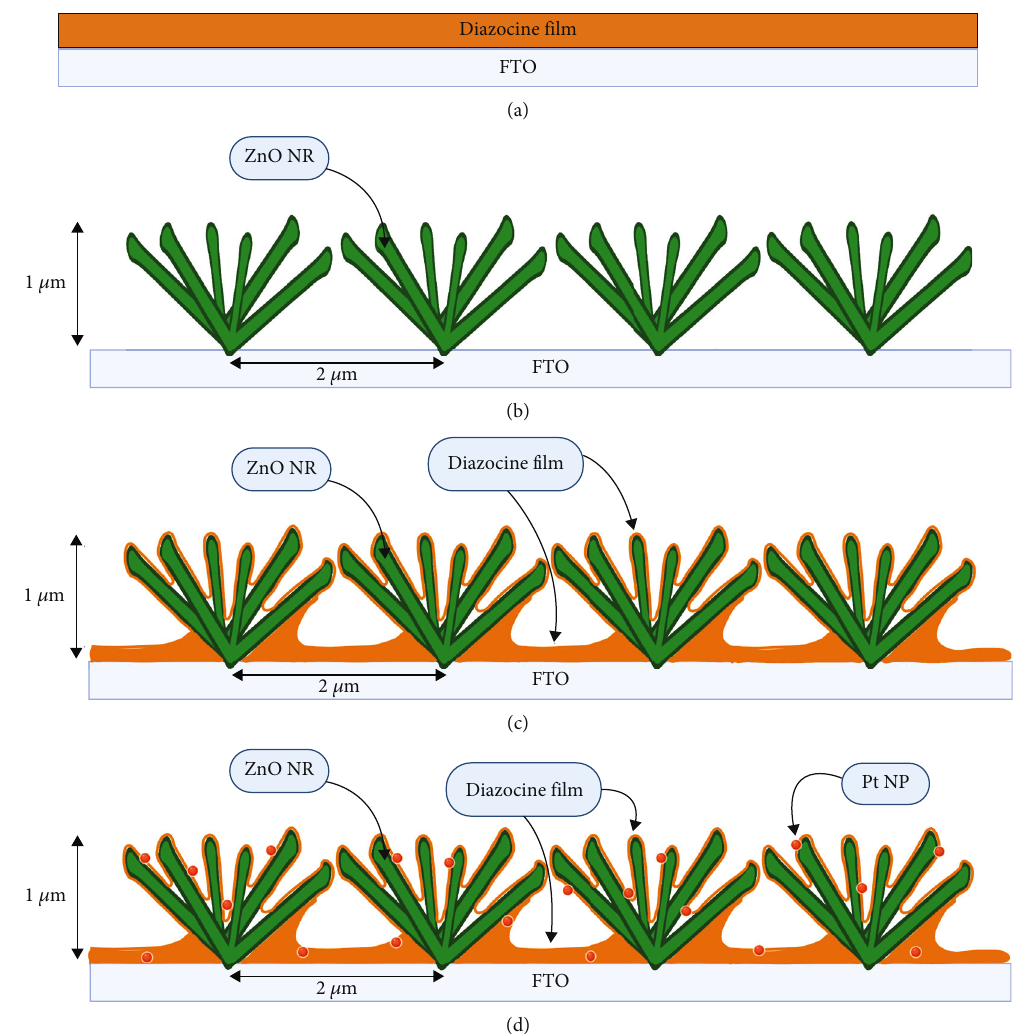
Figure 2: Schematic illustration of (a) diazocine fi lm on FTO; (b) ZnO NR; (c) diazocine fi lm/ZnO NR hybrid; and (d) diazocine fi lm/ZnO NR/Pt NP